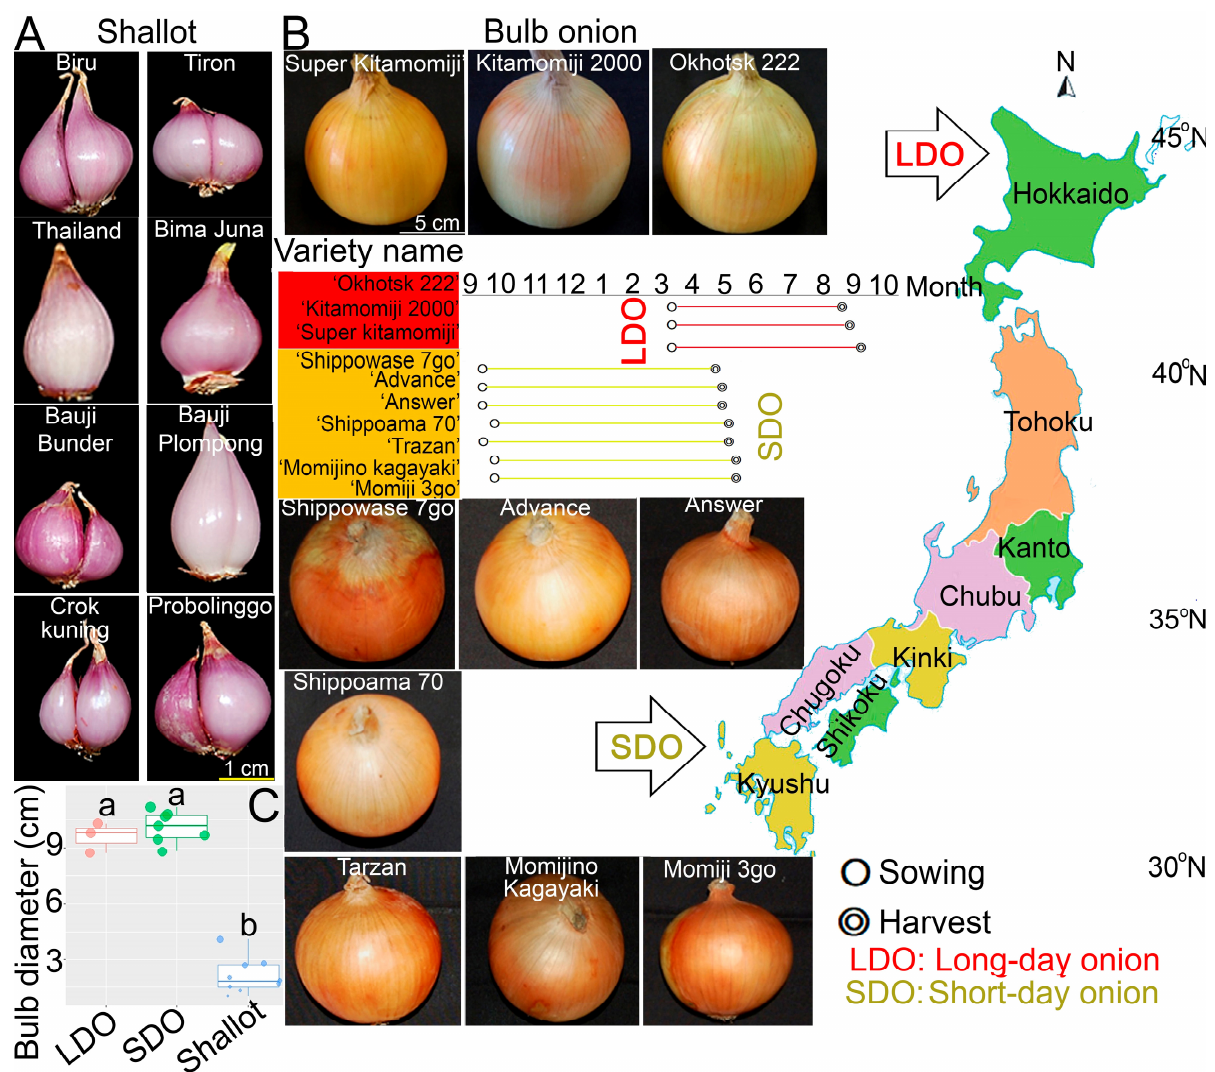
Figure 1. Phenotypes of the investigated Indonesian shallot landraces and Japanese long-day and short-day onions (LDO and SOD, respectively) as well as bulb diameter (cm). ( A , B ) phenotypes of eight Indonesian shallot landraces and three Japanese LDO and seven SDO varieties. ( C ) Bulb diameters of the investigated genotypes. Values represent means calculated from three independent replicates ( n = 3). Different letters indicate significantly higher bulb diameter of LDO and SDO compared with shallots using Tukey’s honestly significant difference (HSD)